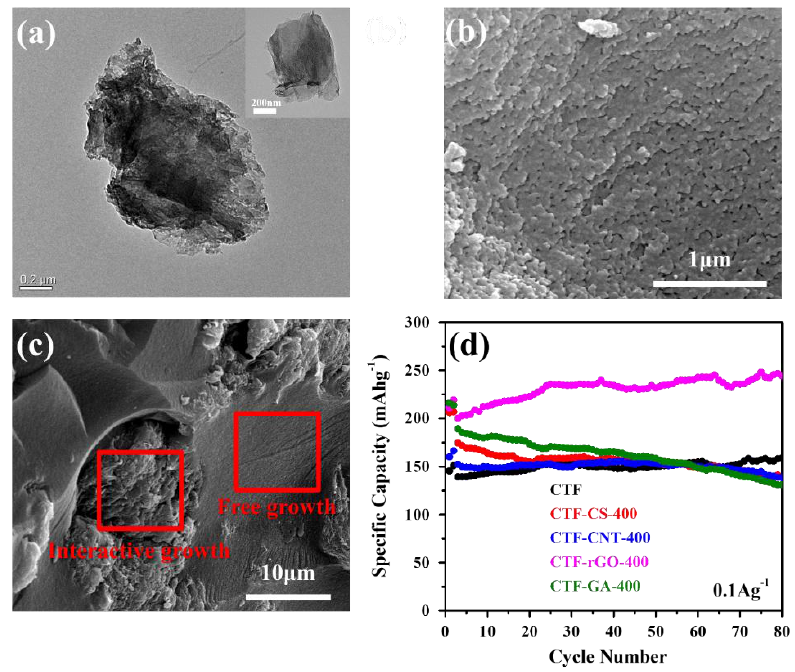
Figure 2. ( a ) TEM images of the CTF-rGO composite and rGO in the inset. ( b,c ) SEM images of the CTF-rGO composite and the CTF-GA composite, respectively. ( d ) The discharge capacities of CTF and all the carbon-based composites measured over 80 cycles at 0.1 A/g.